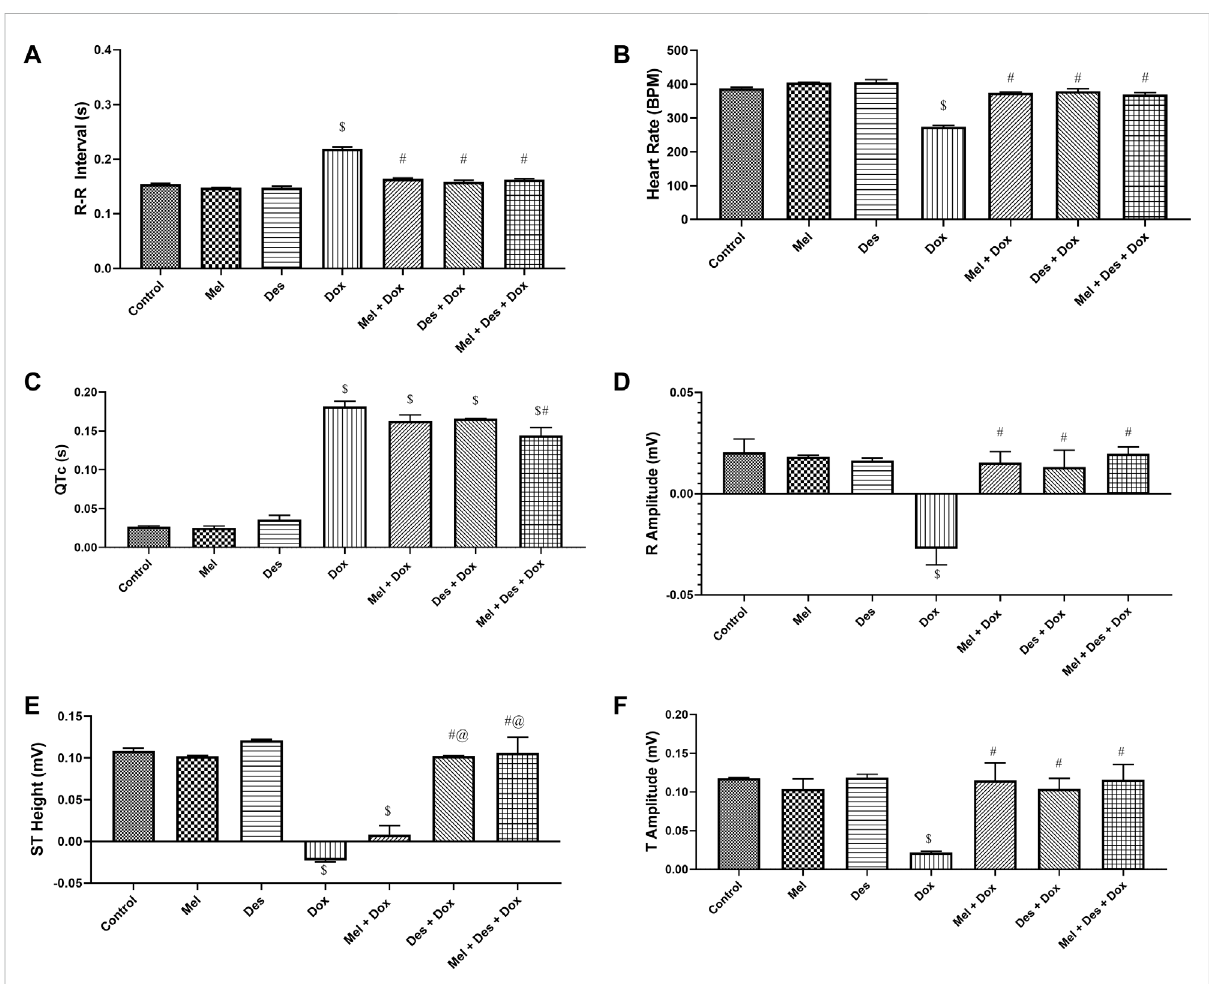
FIGURE 6 GraphsshowingthestatisticaldifferencebetweengroupsregardingECGmeasurements.$:signi fi cant versus control,#:signi fi cant versus Dox, @: signi fi cant versus Mel-Dox, *: signi fi cant versus Des-Dox. Mel: melatonin; Des: deferoxamine; Dox: